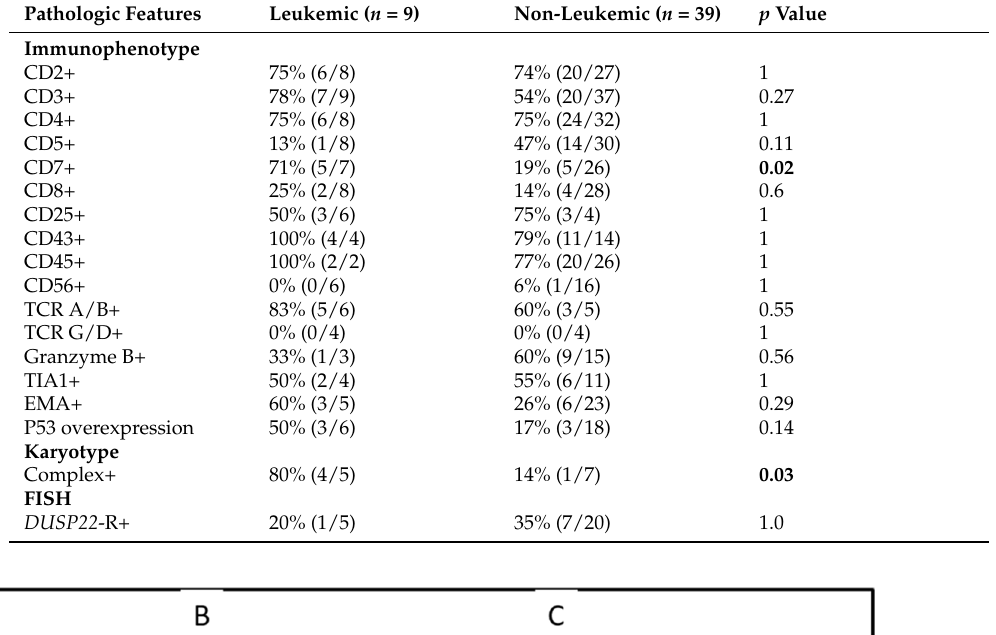
Table 3. Pathologic Features of ALK-negative Anaplastic Large Cell Lymphoma Cases (Leukemic vs. non-Leukemic Group).